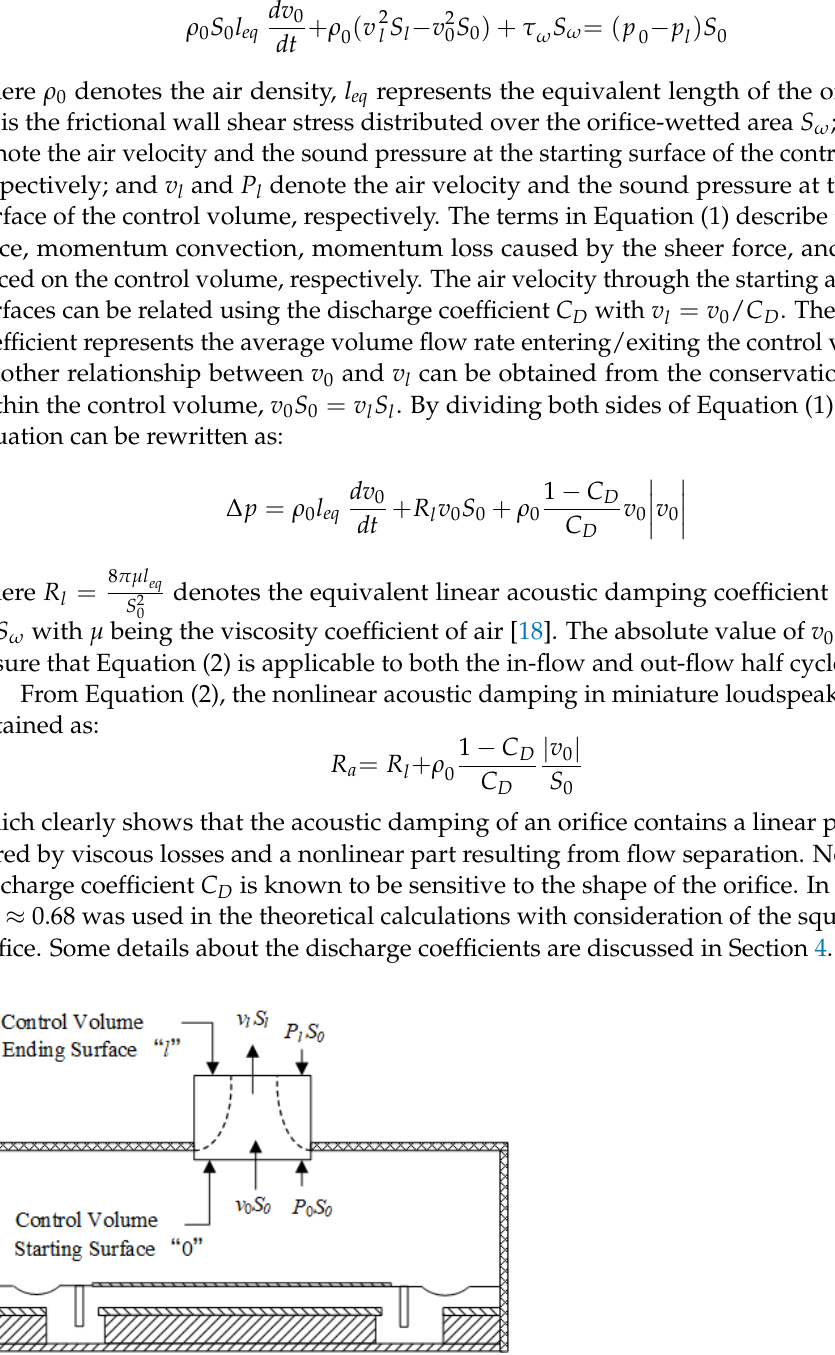
Figure 2. Control volume used in nonlinear acoustic damping deviation.